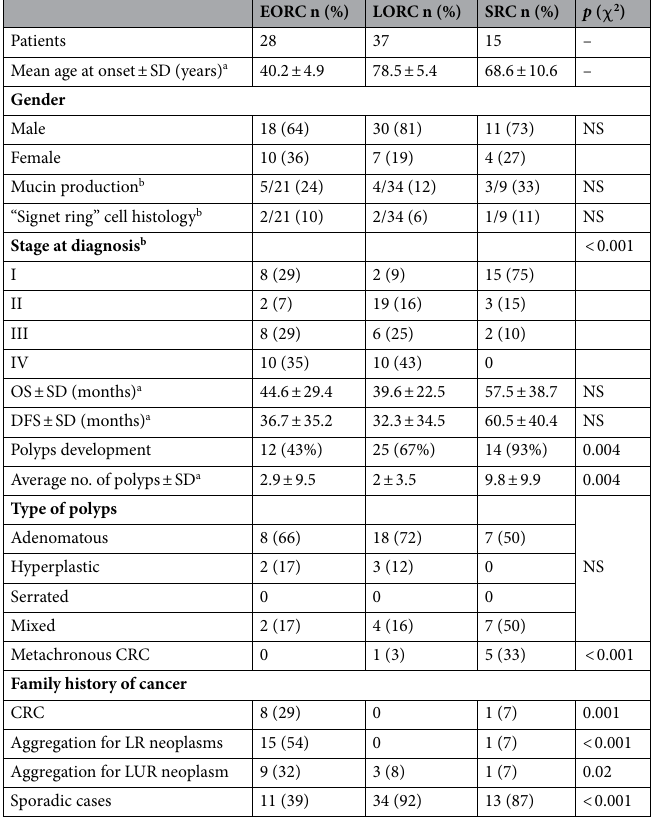
Table 1. Clinical, pathological and familial features of the patients included. a Statistical comparison was performed using Student’s t-test. b Percentages shown are based on varying total numbers as some cases were excluded because only one biopsy was taken (stage D), or because tumors were severely dysplastic with “in situ” carcinoma and it was not possible to study any other characteristic. DFS, disease-free survival; EORC, early-onset rectal Cancer; LR, lynch-related; LUR, lynch-unrelated; No, number; NS, not significant; LORC, late-onset rectal cancer; OS, overall survival; SD, standard deviation; SRC, Synchronous rectal cancer.